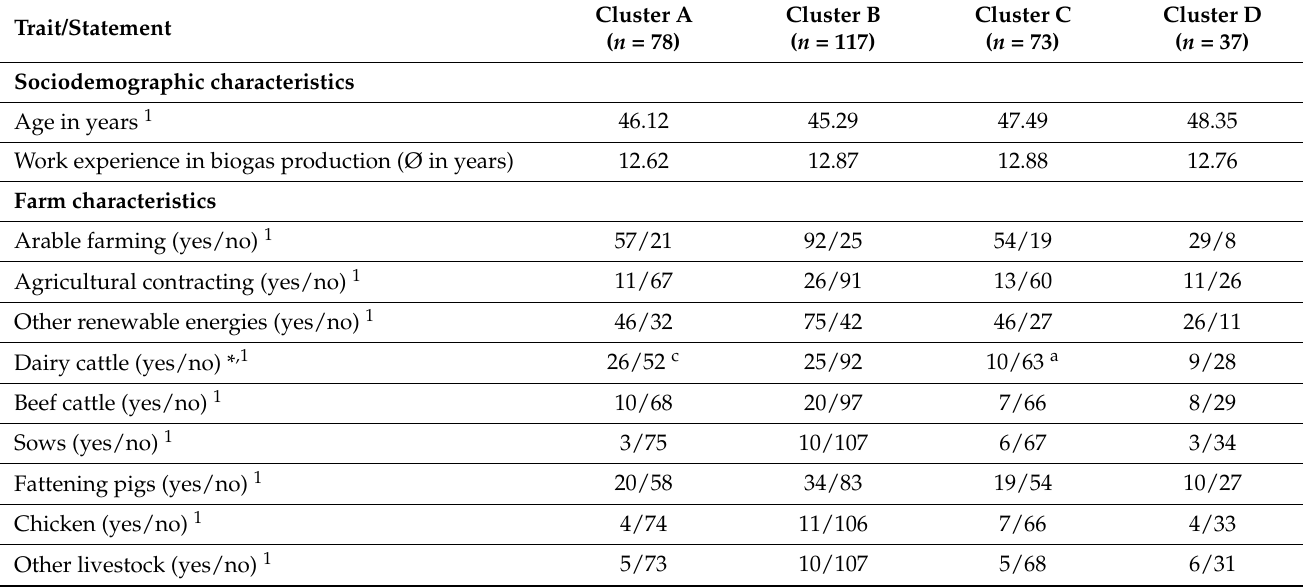
Table 5. Cluster description: Sociodemographic and farm